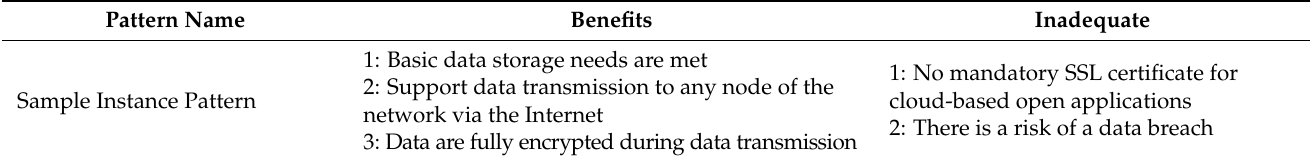
Figure 6. Sample instance pattern. Table 4. Single-instance pattern characteristics